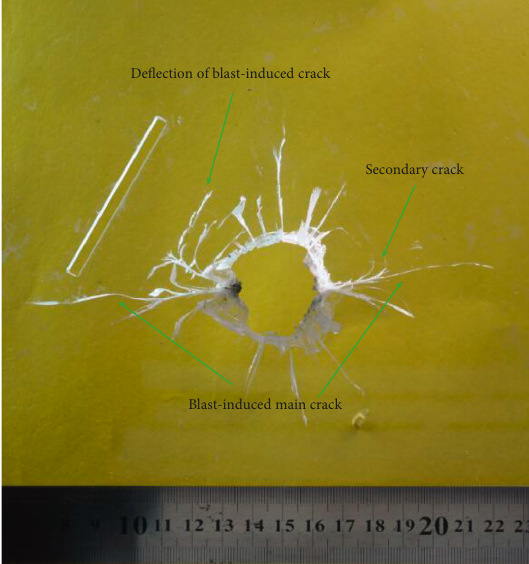
Figure 24: Blasting effect drawing for case SN